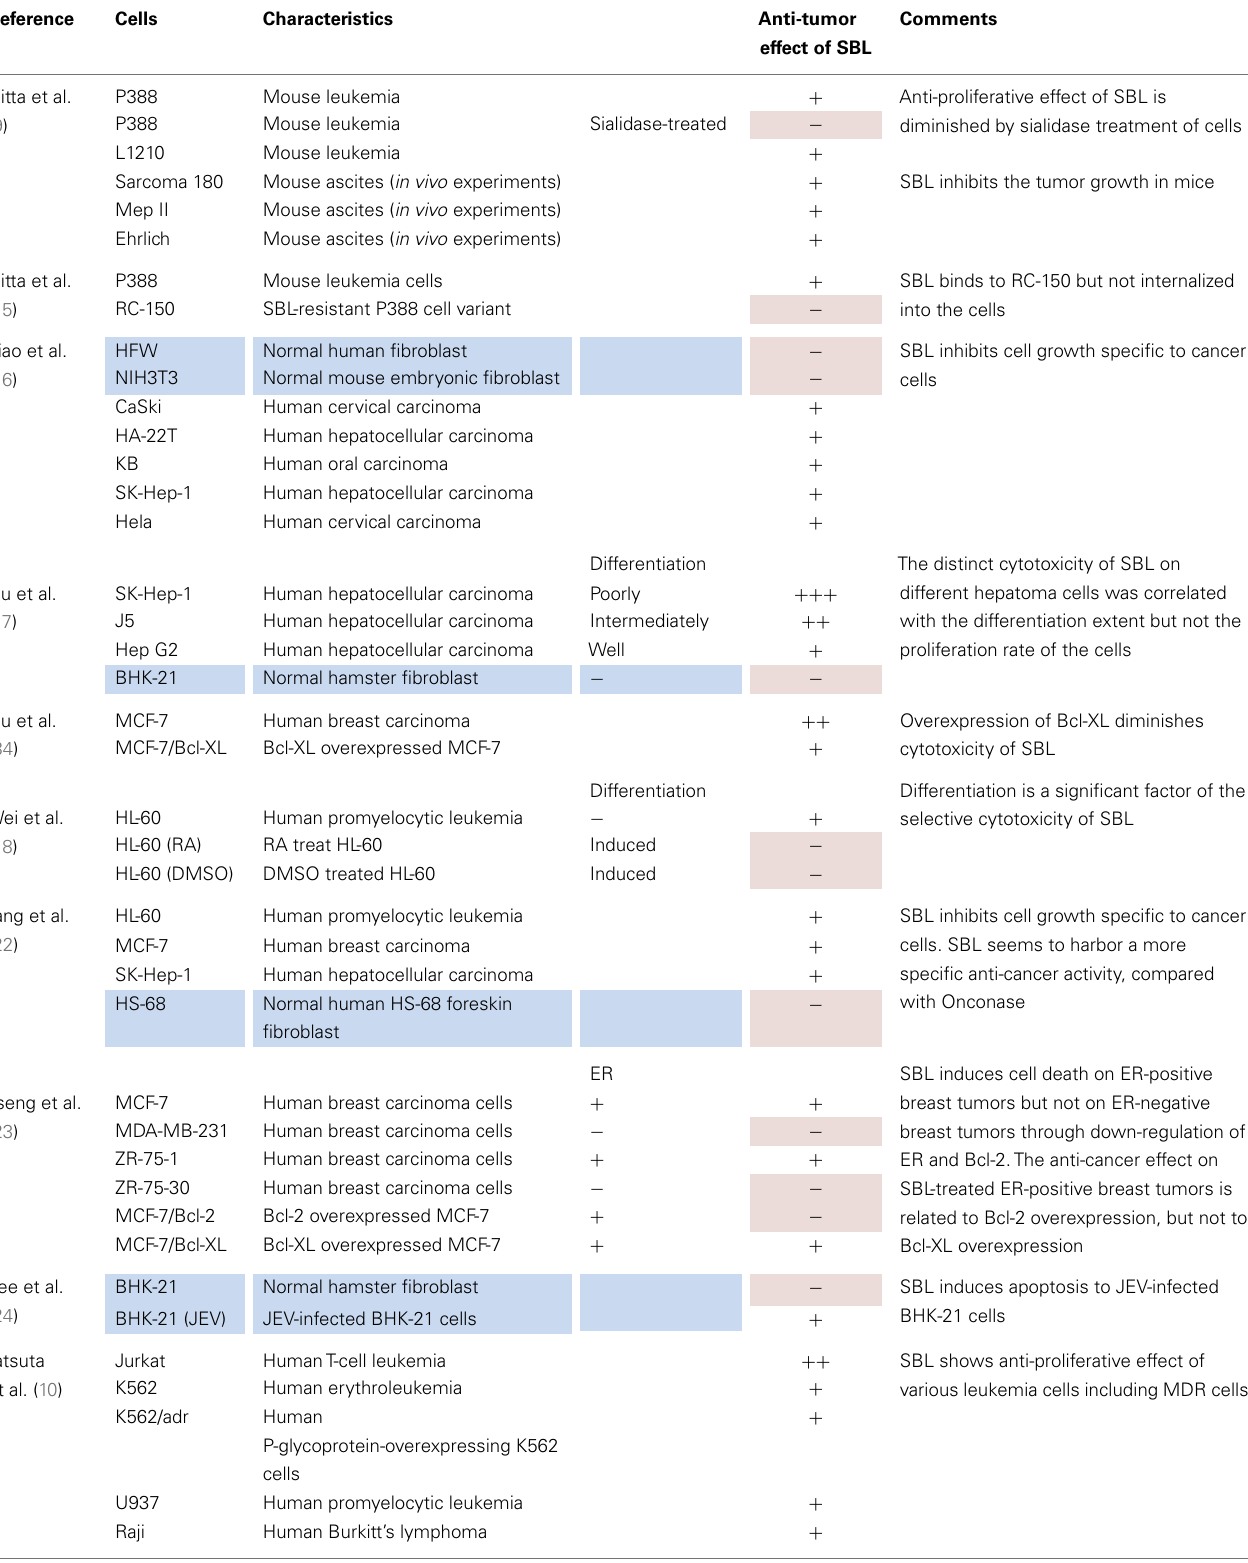
Table 1 | Cells that are reported to be sensitive or insensitive to SBL